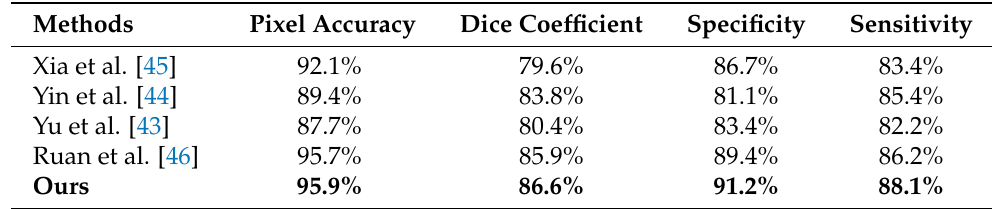
Table 1. Quantification results of our proposed method and the state-of-art renal mass segmentation methods on the KiTs19